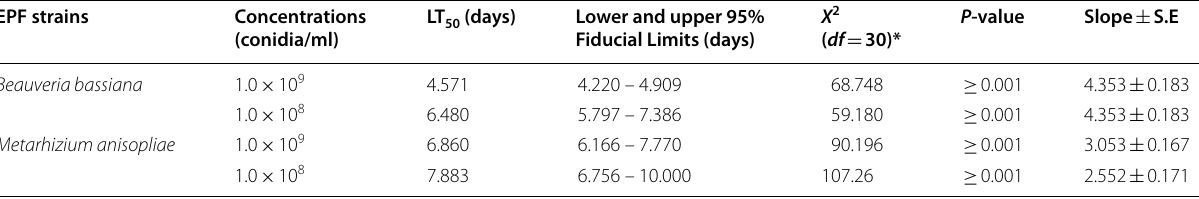
*Since the significance level is less than 0.150, a heterogeneity factor is used in the calculation of confidence limits